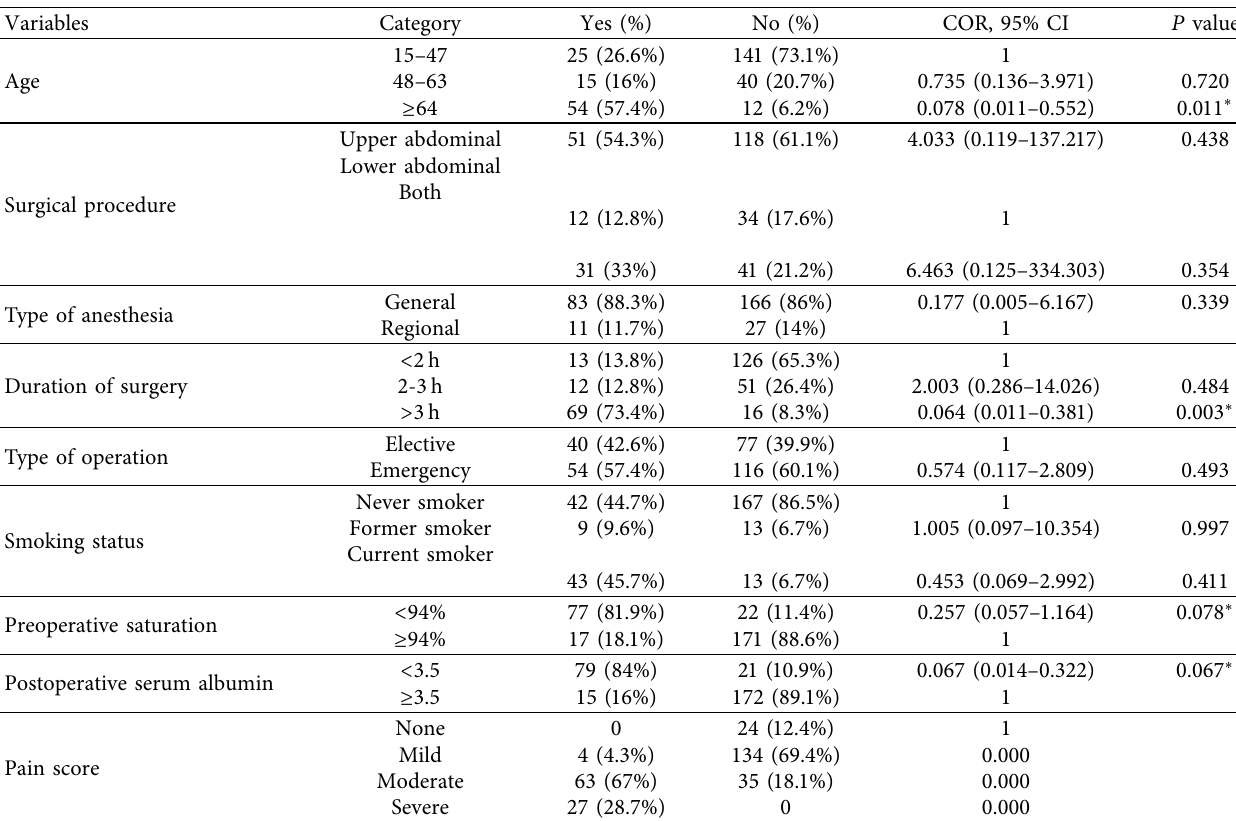
Table 4: Bivariate analysis to assess the association of variables with postoperative pulmonary complications in surgical patients in public hospitals, Ethiopia.